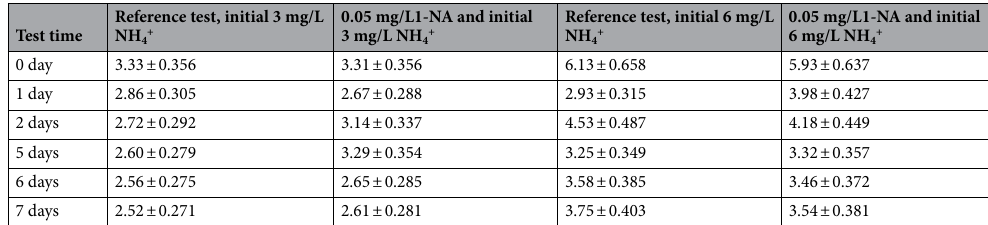
Table 1. Total mineral nitrogen concentration in river water